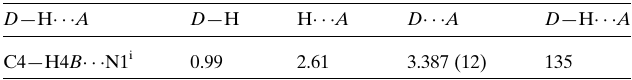
Table 1 Hydrogen-bond geometry (A˚ , (cid:3) ).